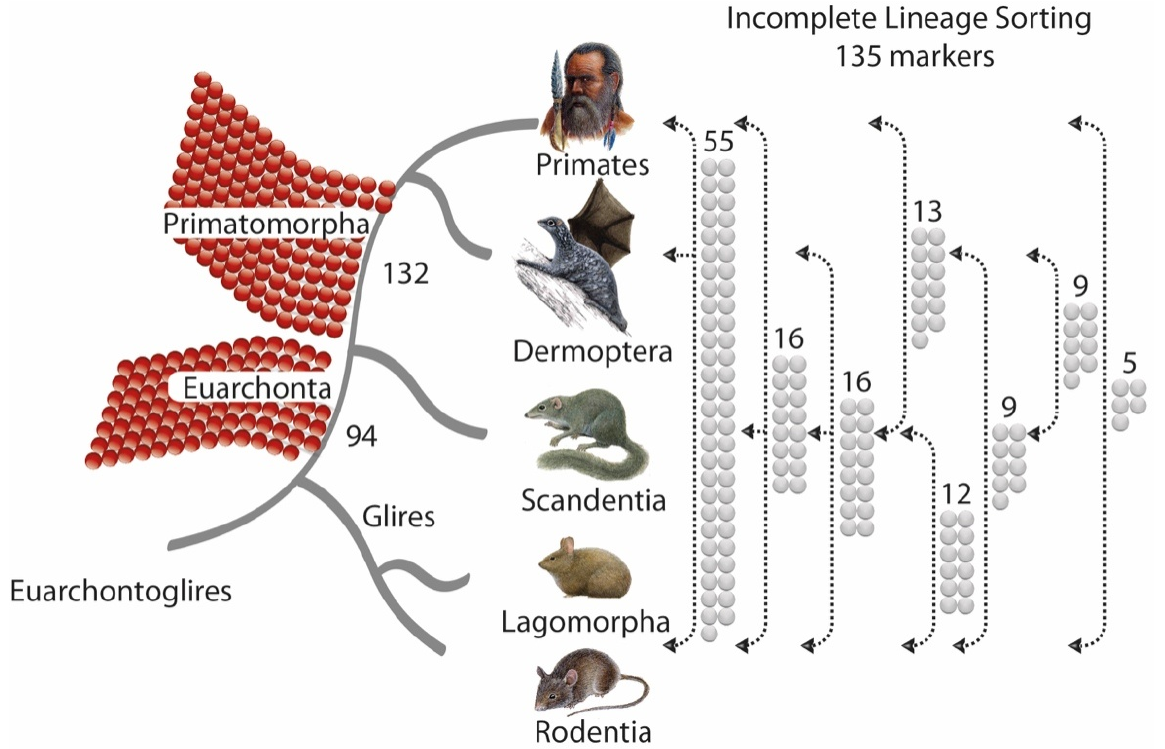
Figure 3. Phylogenetic reconstruction derived from TE insertion presence/absence patterns and statistically analyzed using the 4-LIN tool. Primatomorpha received the most presence/absence support (132 TE insertions), followed by Euarchonta by 94 diagnostic TEs. All markers supporting conflicting tree topologies (together 135) are indicated as grey balls with respective numbers and relationships. Branches assigned by black arrowheads show the presence of shared grey balls (orthologous insertions). All other species represent their absence. For example, nine TE insertions were present in Dermoptera and Scandentia and absent in Primates and Glires. Lagomorpha only accounted for 299 (including ten rodent-lagomorph conflicting patterns) of the 361 TE markers shown here (for details see text). The complete presence/absence matrix is given as Supplementary Table S1. We did not screen for monophyly markers of Glires and Euarchontoglires, monophyly markers of euarchontogliran orders, or phylogenetic signals within them.